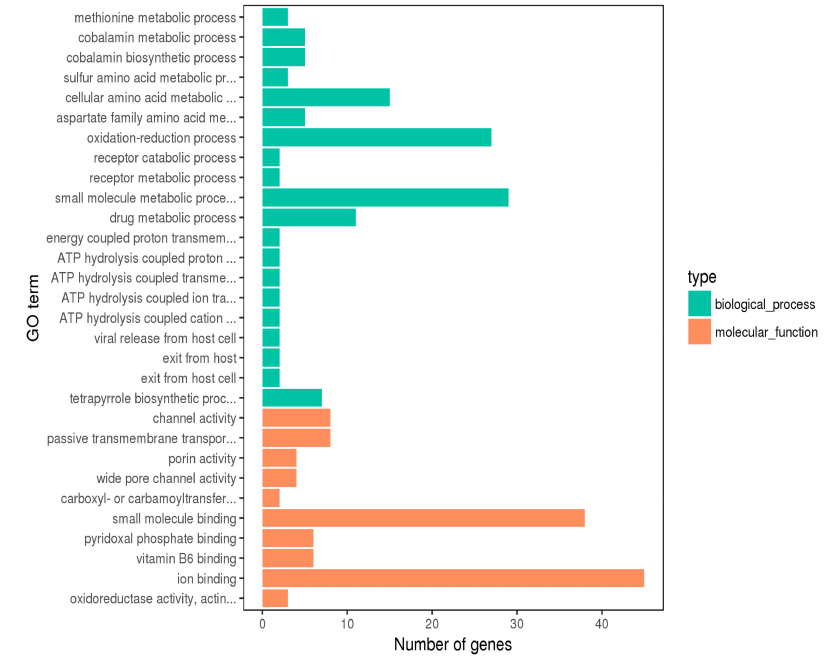
Figure 2. Gene ontology (GO) analysis of di ff erentially expressed genes (DEGs) for SQ_BITC vs SC. The 30 GO terms with the most significant enrichment were